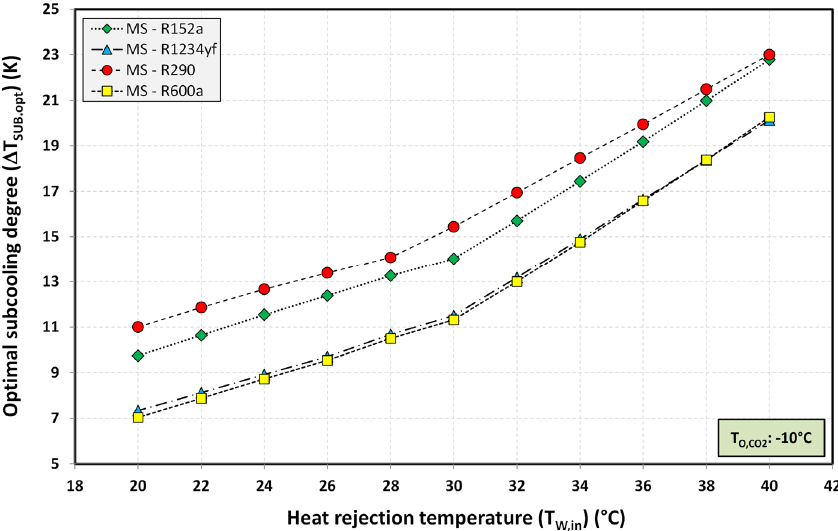
Figure 9. Optimum subcooling degree at different heat rejection temperatures.